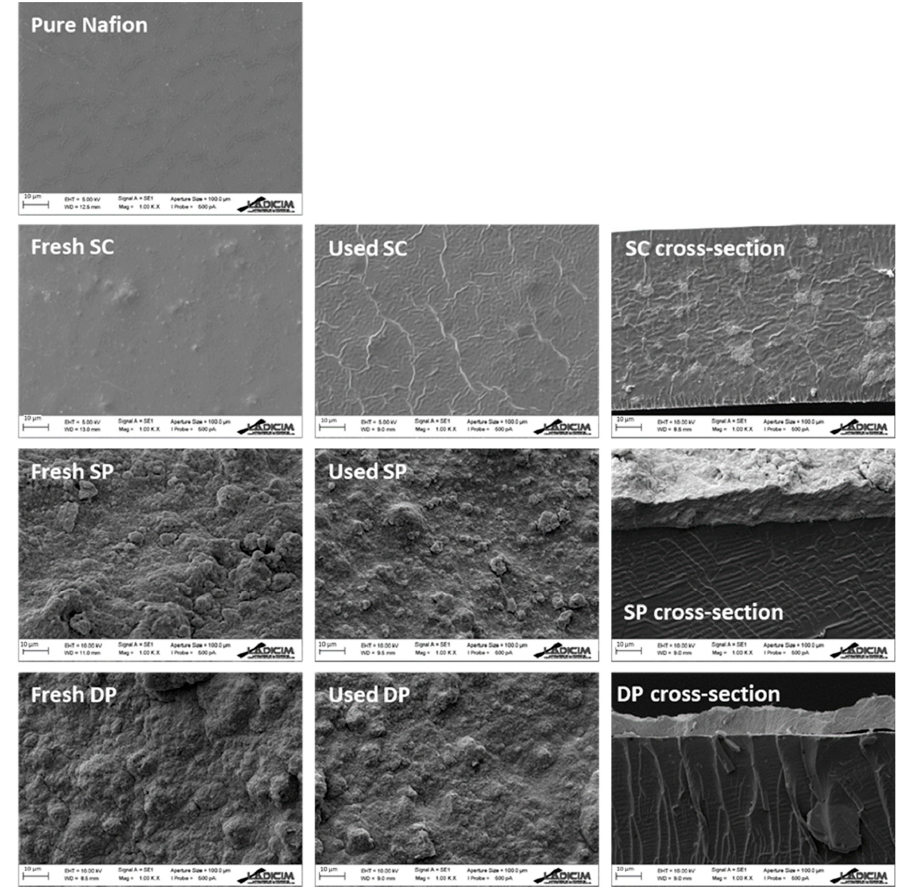
Figure 4. SEM images of pure Nafion, fresh membrane and used membrane surfaces, and fresh membrane cross-section. Scale bar = 10 µm. Table 1. Photocatalyst layer and membrane thickness.